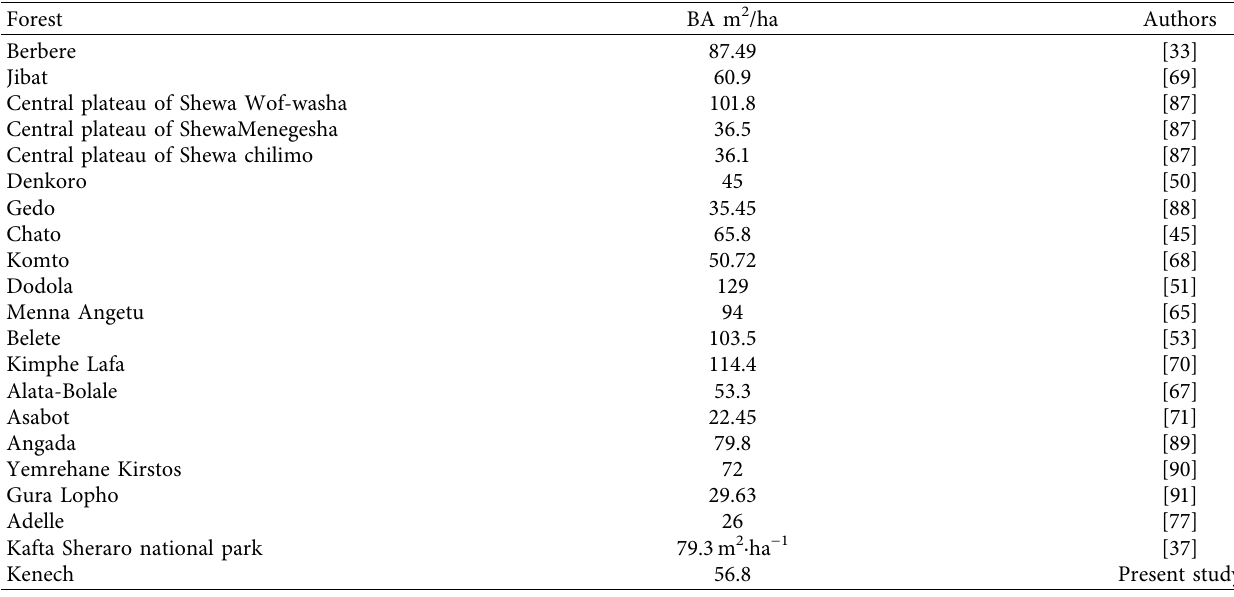
Table 5: Basal area of some of selected forests in